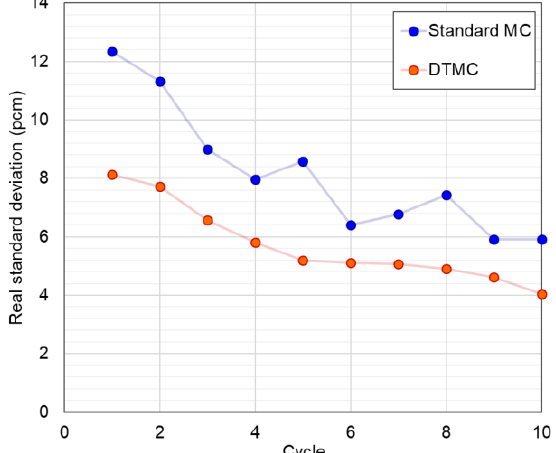
Figure 5. Cycle-cumulative standard deviation in the active cycle